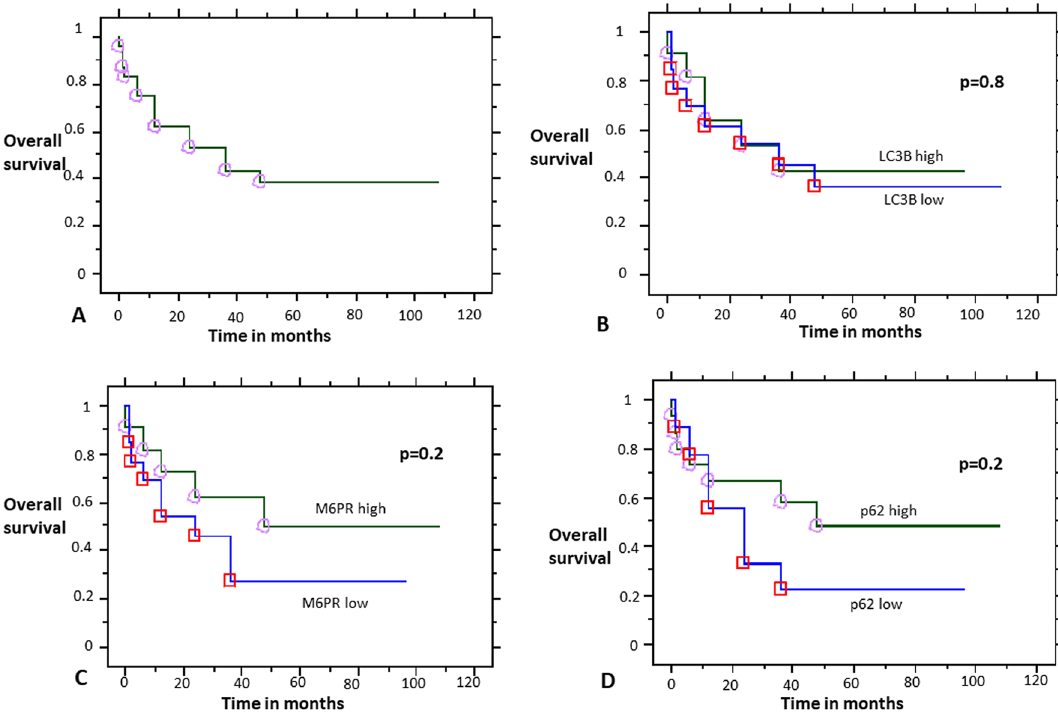
Figure 10. Survival analysis. ( A ) Overall survival analysis. Stratification by LC3B ( B ), M6PR ( C ), and p62 ( D )